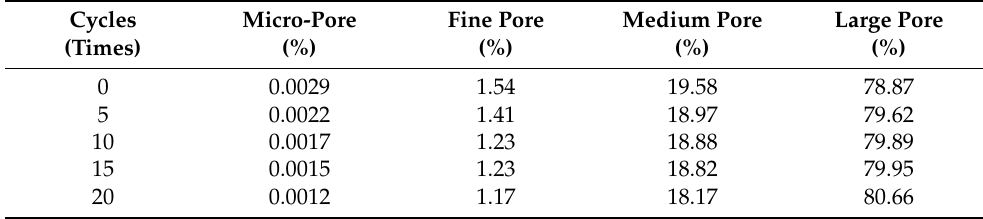
Table 5. Pore size distribution of coarse-grained